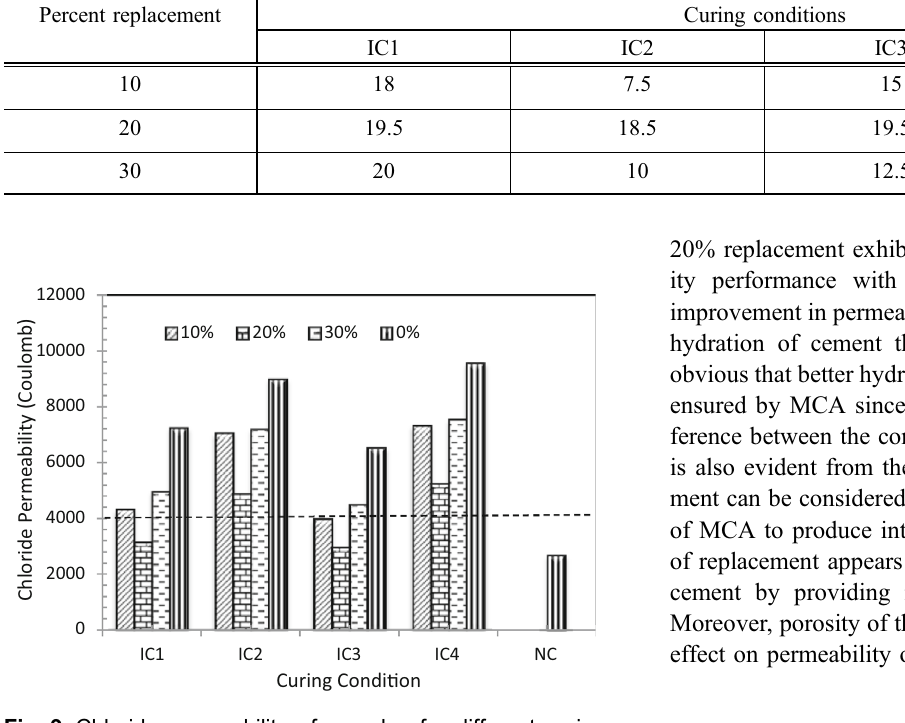
Fig. 9 Chloride permeability of samples for different curing conditions and different percent replacement at a constant w/c ratio of